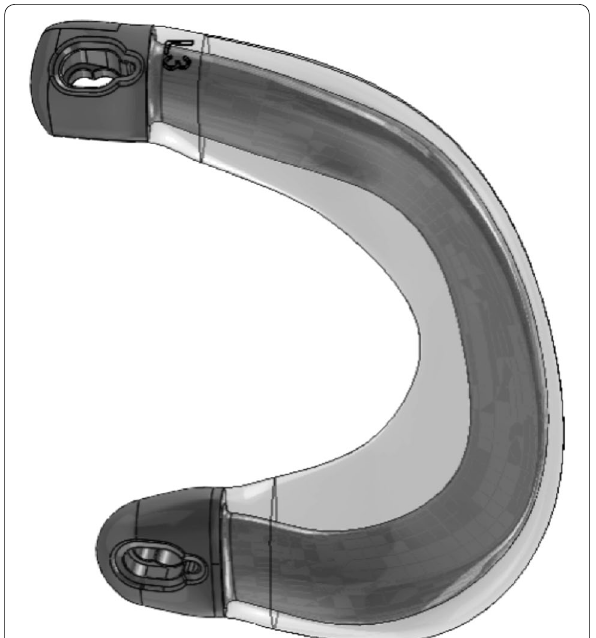
Fig. 1 First-generation meniscus prosthesis, with a reinforcing core and soft outer layer